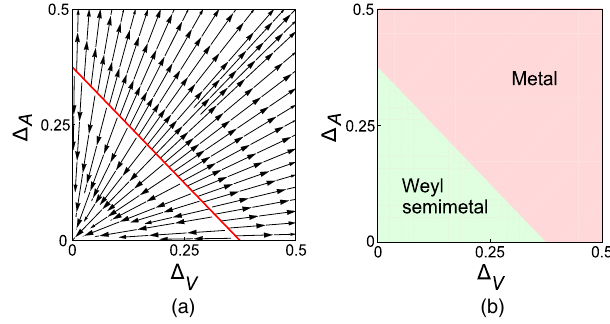
FIG. 10. (a) The RG flow diagram and (b) the phase diagram in − Δ 1 , obtained from Eq. (35). Here Δ the Δ plane, for ϵ V A m ¼ and Δ are, respectively, the strength of potential and axial A potential disorder. The red line in (a) corresponds to the line of quantum-critical points [see Eq. (36)] that in turn defines the phase boundary between the Weyl semimetal and metallic phases, as shown in (b). A similar flow and phase diagram is obtained from the RG calculation performed within the framework of an ϵ expansion [see Eq. (39)]